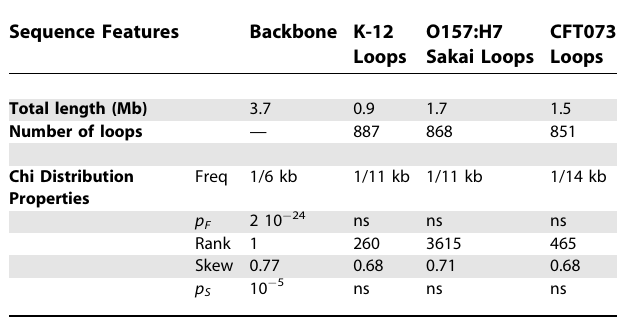
Table 1. Chi Is Overrepresented on the E. coli Backbone but Not on the Loops